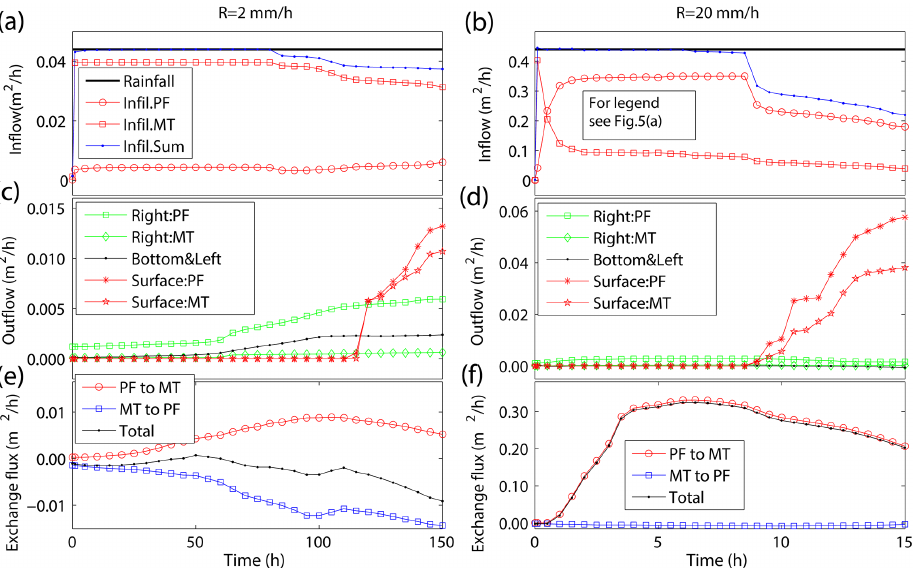
Figure 5. Integrated fluxes for dual-permeability model and 2mmh − 1 (left panels) and 20mmh − 1 (right panels) rainfall. Rainfall and infiltration (a, b) ; outflow at the right, outflow at the left and bottom, and outflow at the surface (c, d) ; exchange between matrix domain (MT) and preferential flow domain (PF) (e, f) , positive for flow from PF to MT and negative for flow from MT to